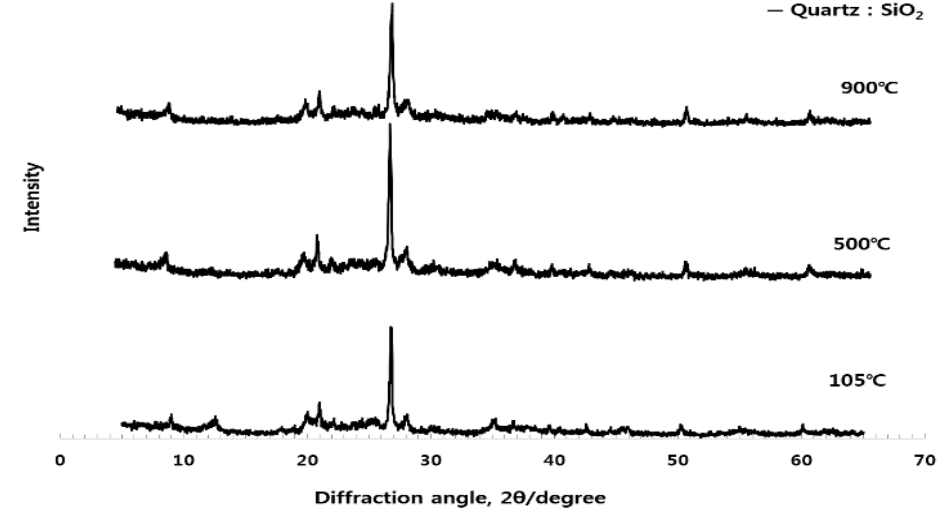
Figure 3. Quantitative analysis of the crystal structure of sludge at different burning temperatures.